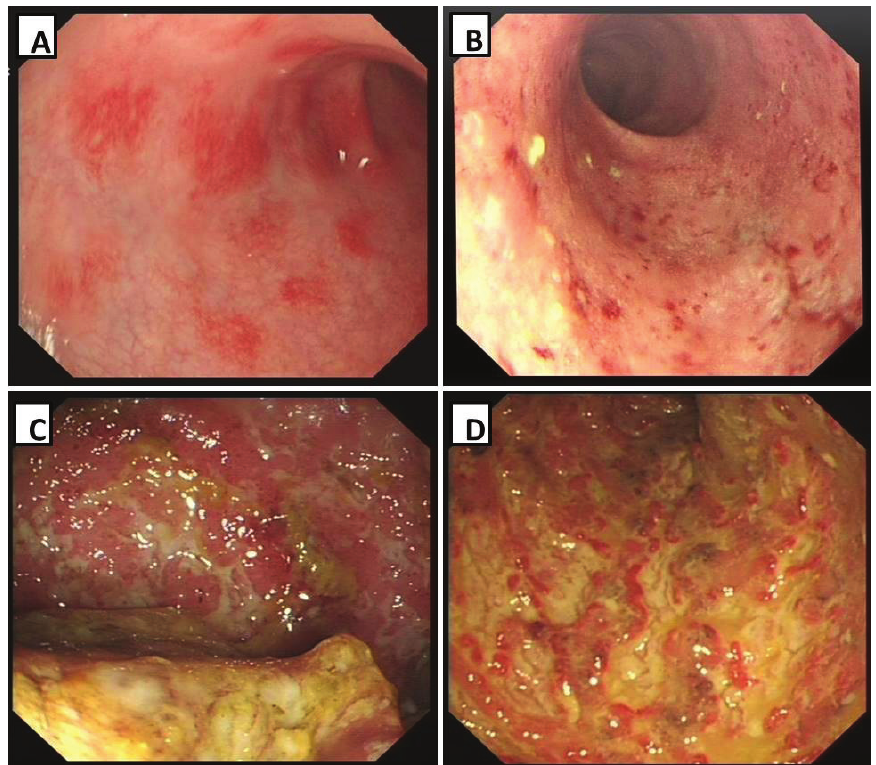
Figure 1. Colonoscopy for ulcerative colitis (A, B: mild/moderate ulcerative colitis of the colon; C, D: severe ulcerative colitis of the